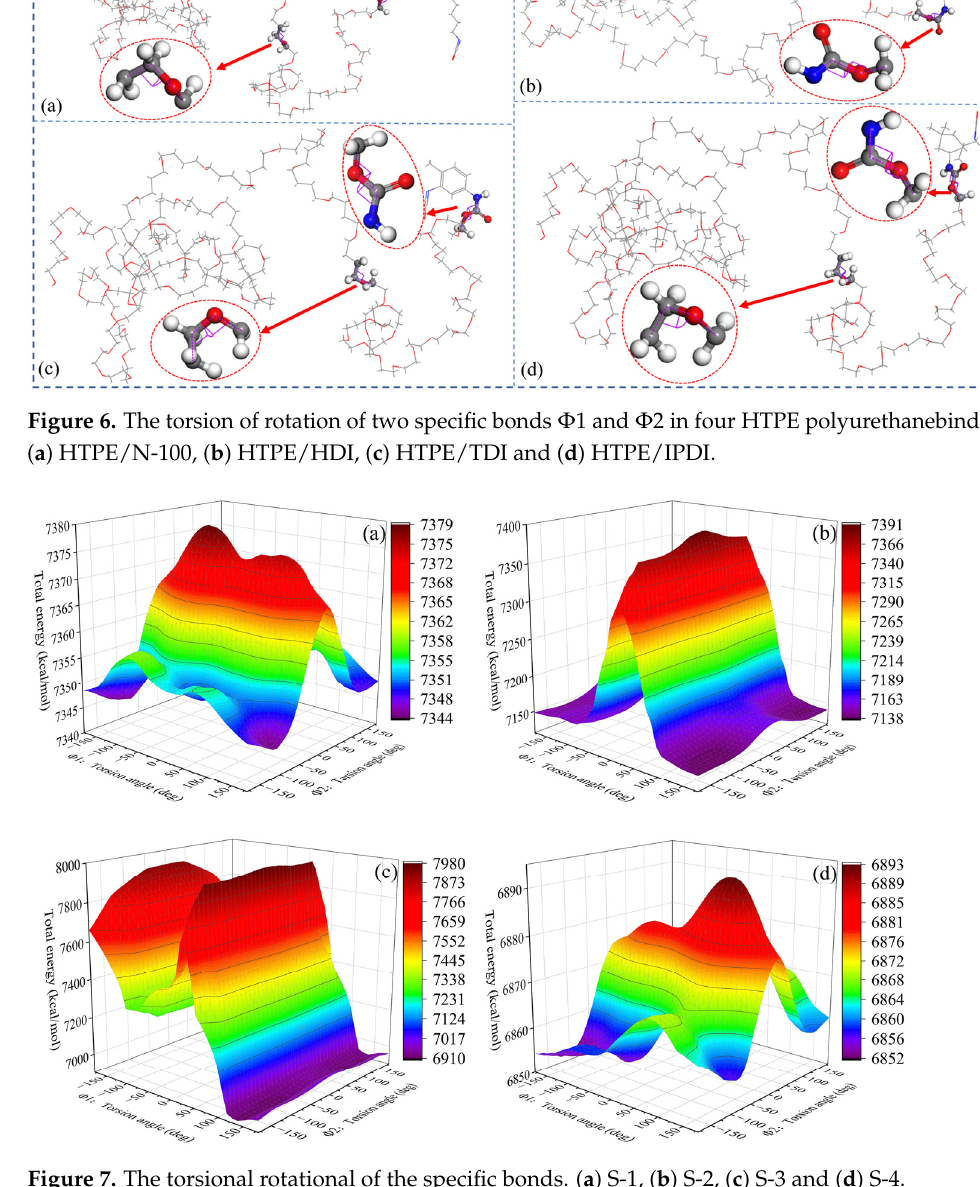
Figure 7. The torsional rotational of the specific bonds. ( a ) S-1, ( b ) S-2, ( c ) S-3 and ( d ) S-4.